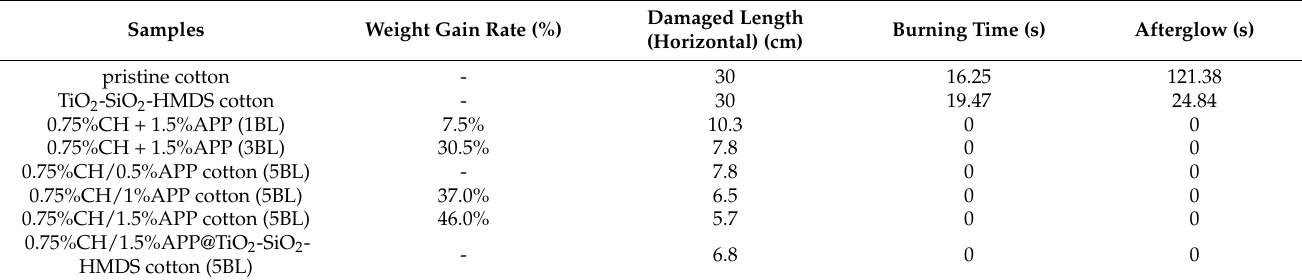
Figure 6. Vertical flame test optical images of cotton samples. Table 4. Vertical flame test data of the uncoated and coated fabrics.